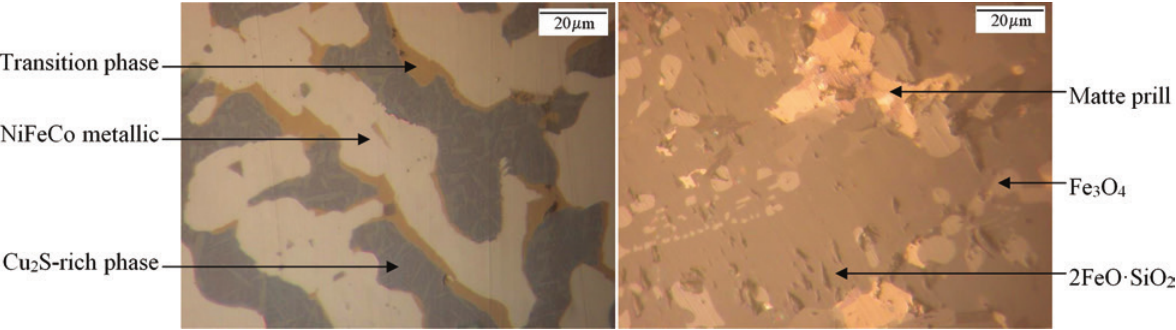
Fig. 3: Micrograph of matte (a) and slag (b) after the converter slag treatment with Fe5C.